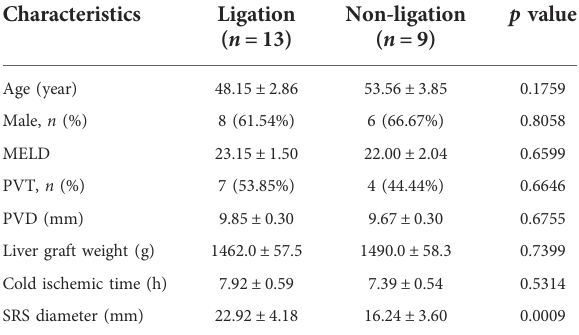
TABLE 3 The characteristics of recipient and donor in 2